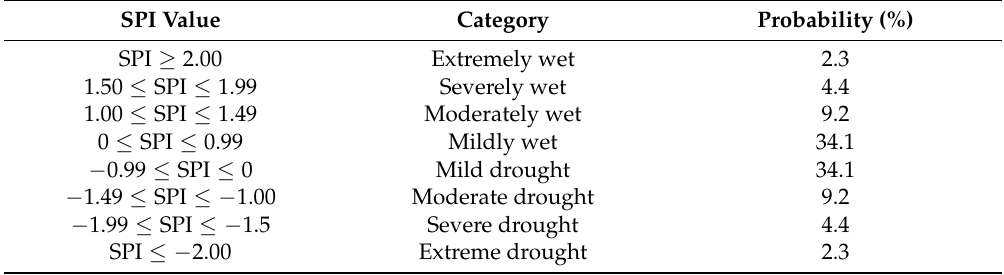
Table 1. Drought severity classification based on SPI value and corresponding event probability